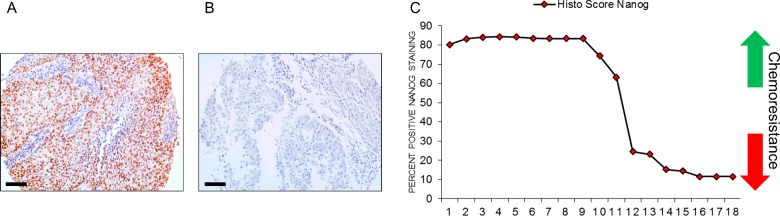
NANOG expression levels in patients with ovarian cancer is correlated to chemoresistanceRepresentative tissue specimens showing high (A) and low (B) NANOG expression; scale bar: 50 μm. (C) Graphical representation of percent NANOG expression in the tissue specimens obtained from 18 patients. The known chemoresistance of these patients in terms of high (green arrow) and low (red arrow) is also shown.